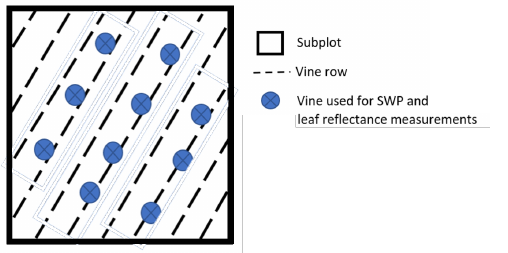
Figure 4. 20 × 20 m subplot with the locations of each targeted vine. SWP—stem water potential.